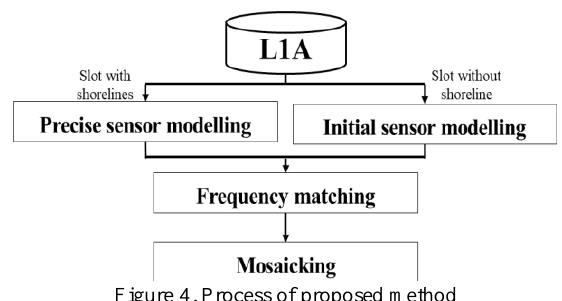
Figure 4. Process of proposed method